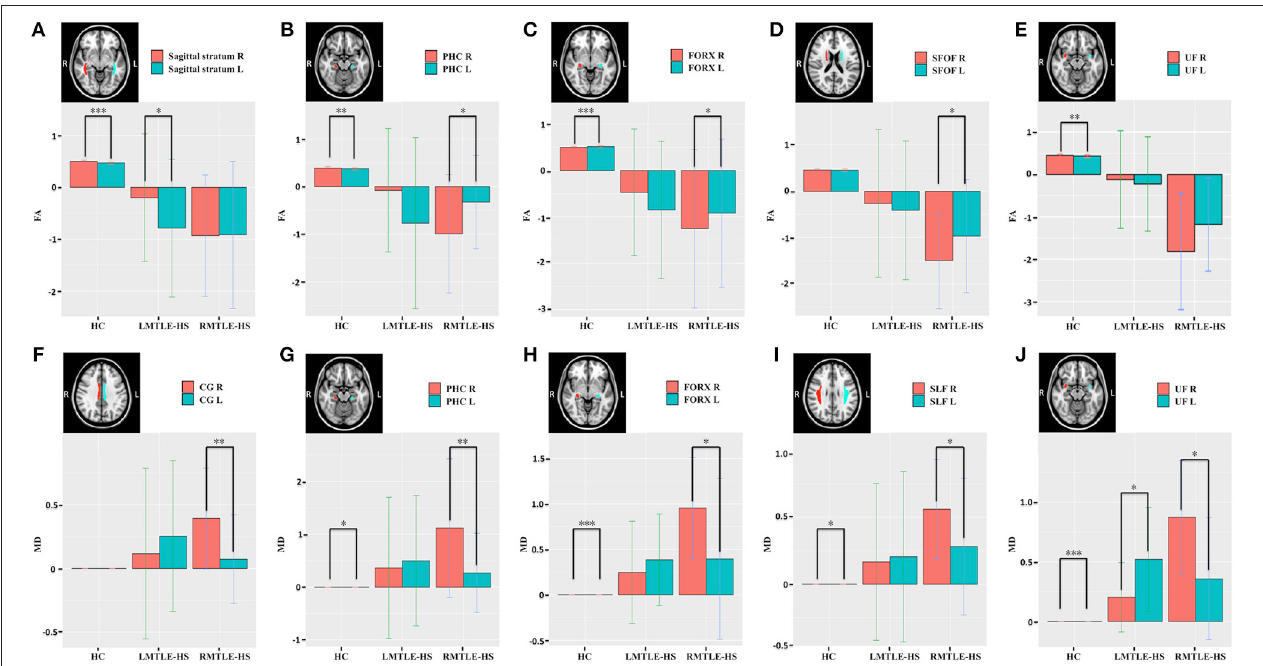
FIGURE 2 | The paired-ROIs asymmetries in HC, LMTLE-HS, and RMTLE-HS were calculated by comparing the FA (A–E) or MD (F–J) values of the paired-ROIs in bilateral hemispheres. The FA and MD values of LMTLE-HS and RMTLE-HS were calculated by using z scores based on the mean of the HC in a given hemisphere. Red represents the FA or MD values of the right hemisphere and blue represents the FA or MD values of the left hemisphere. Rightward asymmetry was defined as having a larger FA/MD value of the right brain than the left, and leftward asymmetry was left ROI value larger than right (* P < 0.05; ** P < 0.01; *** P < 0.001). PHC, parahippocampal cingulum; FORX, fornix; SFOF, superior fronto-occipital fasciculus; UF, uncinate fasciculus; CG, cingulum fibers within the cingulate gyrus; SLF, superior longitudinal fasciculus.